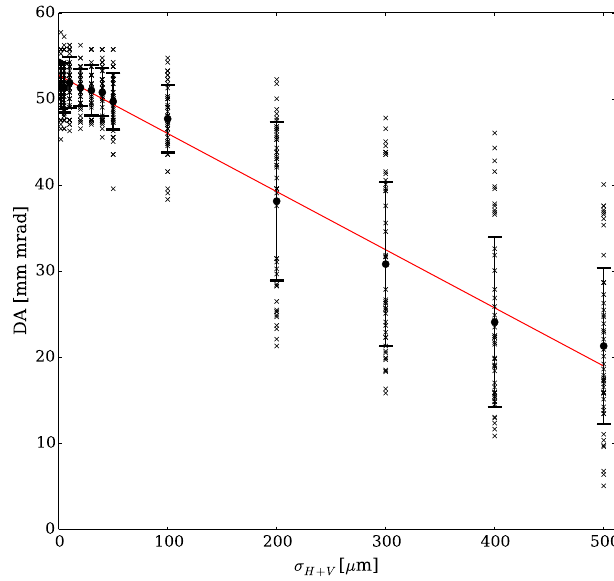
FIG. 17. The DA as a function of horizontal and vertical cell misalignment errors for the NORMA racetrack lattice with f RT ¼ 0 . 91 and L ¼ 2 . 2 m. The red line shows a minimum chi- RT squared fit to the average reduction in DA with σ